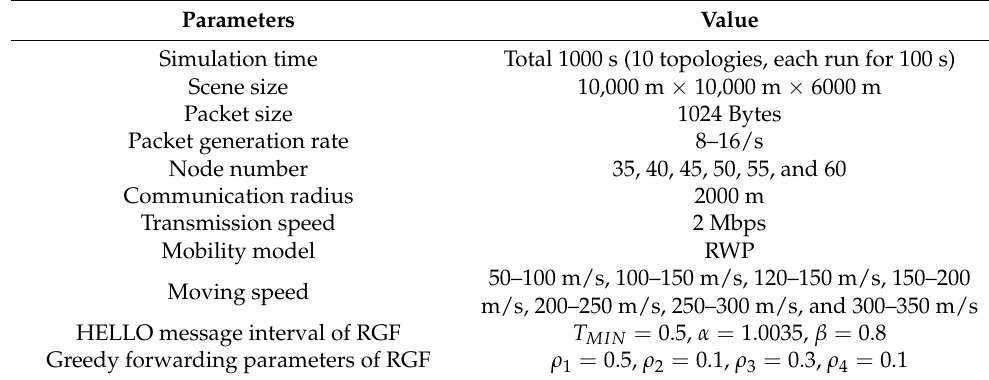
Table 1. Simulation parameters.